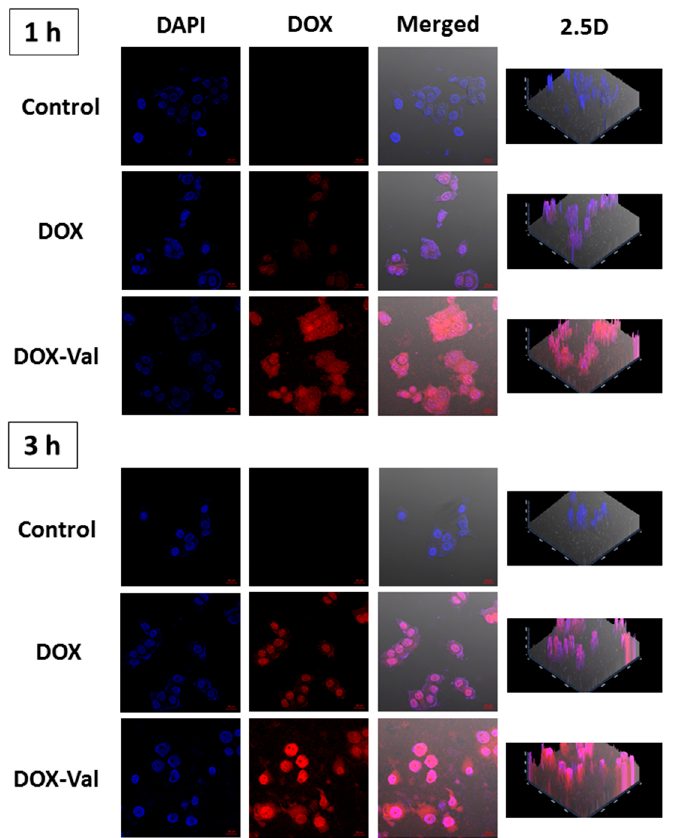
Figure 3. Cellular distribution of DOX and DOX-Val in MCF-7 cells observed by CLSM. DOX and DOX-Val (10 μ M) were incubated for 1 h and 3 h in MCF-7 cells. Red and blue colors indicate DOX and 4 ′ ,6-diamidino-2-phenylindole (DAPI), respectively. DAPI, DOX, merged, and 2.5 D images are presented. The 2.5 D image can provide spatial information between 2D and 3D images. The length of the scale bar in the image is 20 μ m.